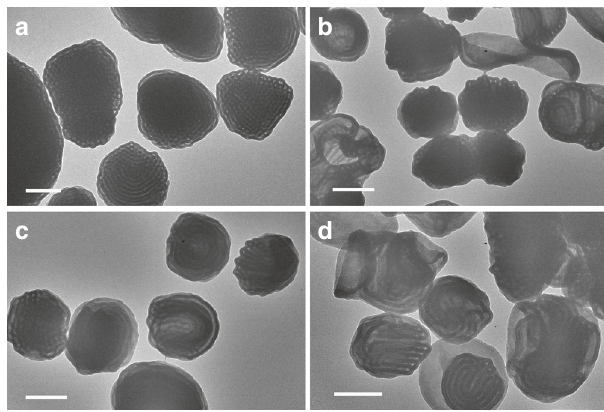
Fig. 3 Transmission electron microscopy (TEM) micrographs of PDMA 29 - b -P(St- alt -PFS) x block copolymer (BCP) particles synthesized at 30% w/v and 70 °C using 2% cosolvents. a Toluene, x = 465, b tetrahydrofuran (THF), x = 455, c N,N -dimethylformamide (DMF), x = 405, d dioxane, x = 450 (all scale bars: 500 nm). PDMA poly( N,N -dimethylacrylamide), St